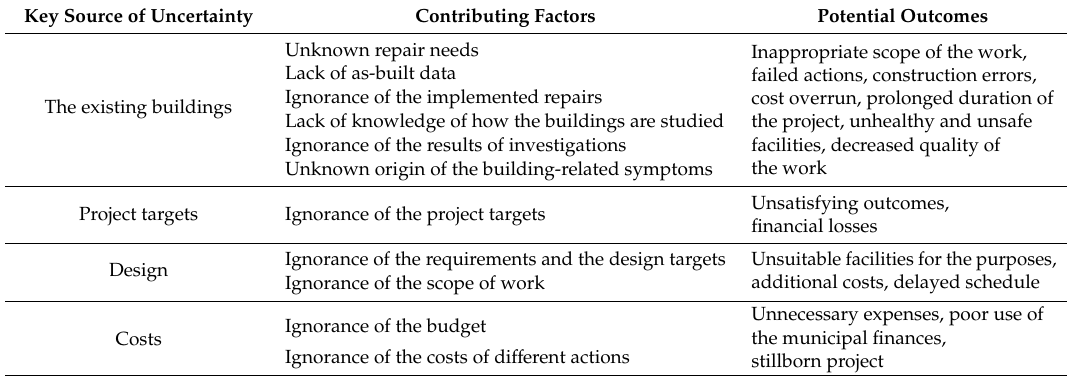
Table 3. The sources and the potential outcomes of the uncertainty concerning the project. Key Source of